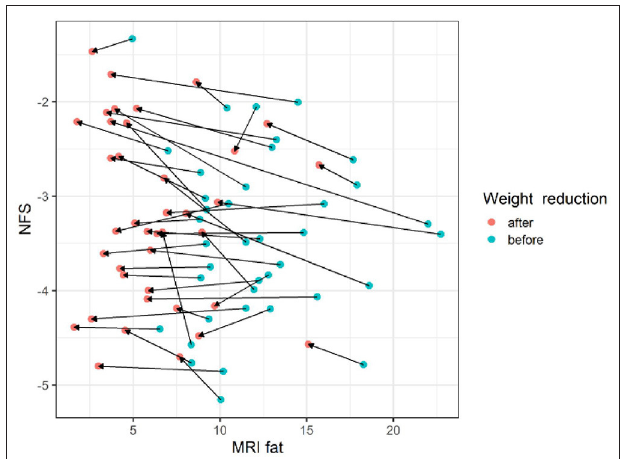
FIGURE 5 | The changes of NFS according to MRI fat before and after body weight reduction. Regardless of the change in the MRS fat fraction according to the change in body weight, there was little change in the NFS value. MRS, magnetic resonance spectroscopy; NFS, NAFLD fibrosis score. Blue circle, before weight reduction; red circle and arrows, after weight